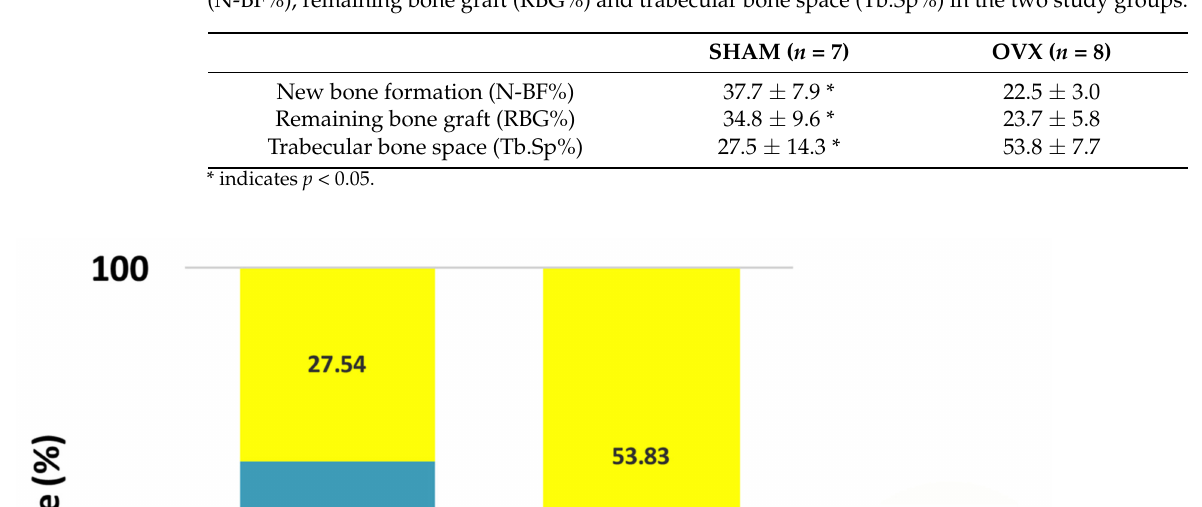
Table 2. Quantitative histomorphometric data showing mean ± SD values for new bone formation